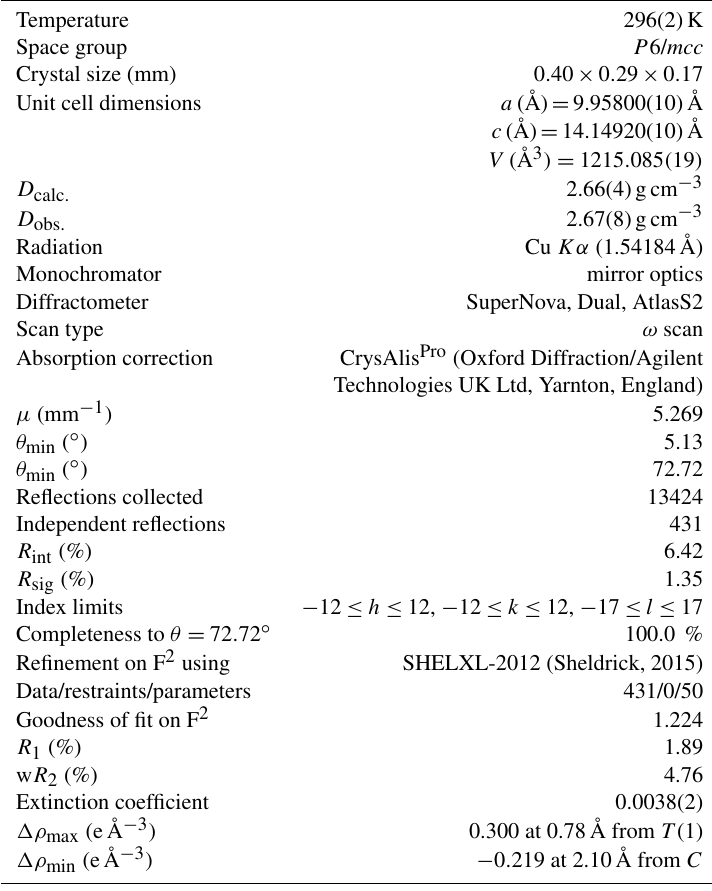
Table 6. Crystal data and structure refinement for laurentthomasite.